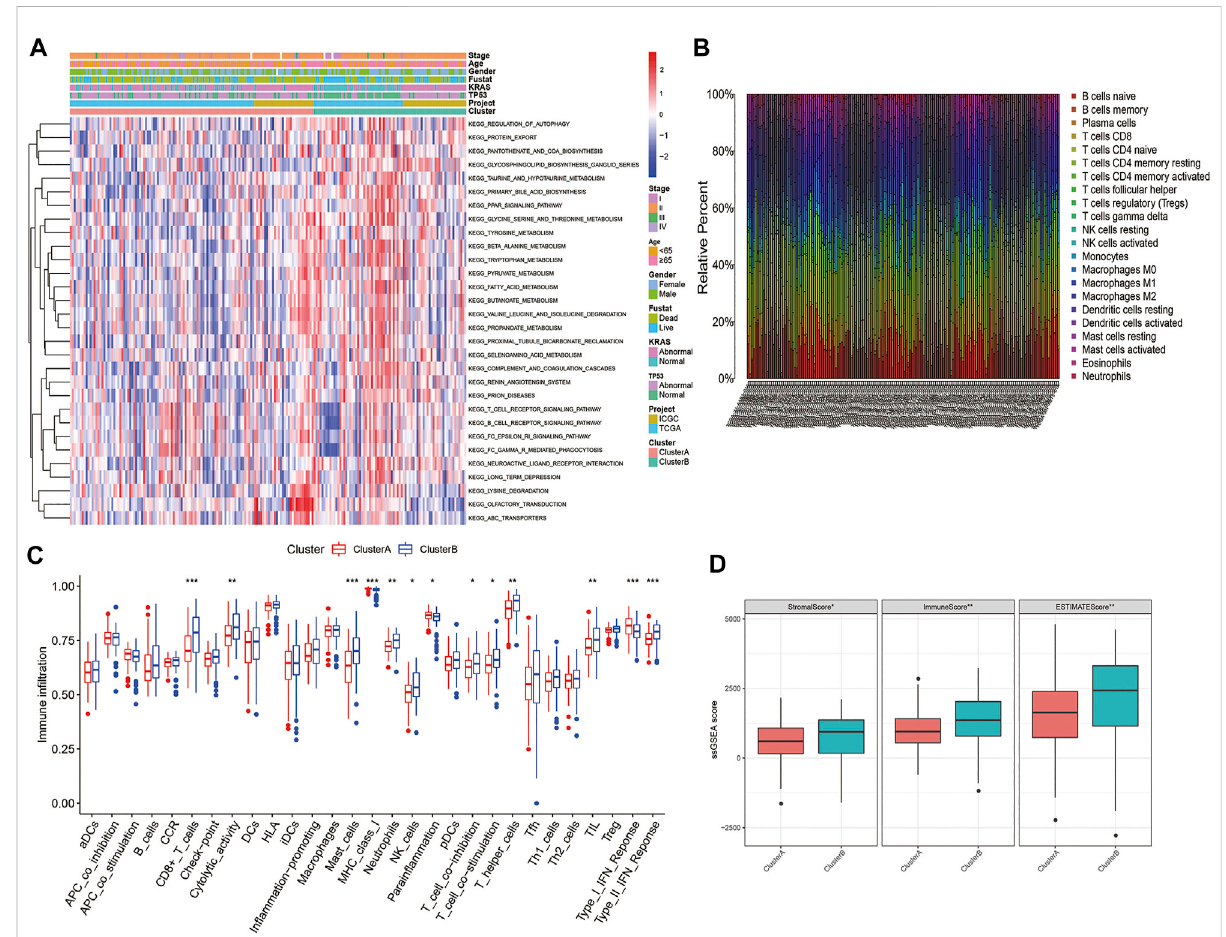
FIGURE 3 Correlations of TIME and two PC subtypes: (A) GSVA analyzed the biological pathways of two angiogenesis subtypes in all samples from TCGA and ICGC cohorts; (B) The relative percentage of 22 subpopulations of immune cells in PC; (C) 29 TIME cells in fi ltration abundance of two angiogenesissubtypes; (D) CorrelationsbetweenthetwoangiogenesisclustersandTMEscore.***p < 0.001,**p < 0.01,*p < 0.05andnotsigni fi cant (p > 0.05) by repeated measures with the Wilcoxon